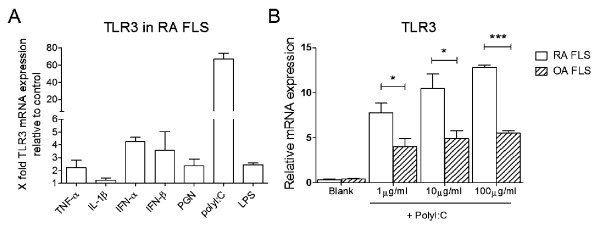
Regulation of TLR3 expression in RA FLSs stimulation by various inflammatory factors. (A) FLSs from RA patients (n = 3) were stimulated with TNF-α, IL-1β, IFN-α, IFN-β, PGN, poly(I:C) and LPS for 24 hours, and TLR3 expression was regulated to different extents. Values are mean ± SEM fold induction of TLR3 mRNA relative to unstimulated cells (set as control). Baseline expression (control group) was set at 1. (B) Induction of TLR3 mRNA expression in FLSs from RA patients (n = 3) and OA patients (n = 3) with series poly(I:C) dose stimulation. Data are presented as means ± SEM from three independent experiments. Levels of significance were calculated by using Student's t-test (*P < 0.05, ***P < 0.001).